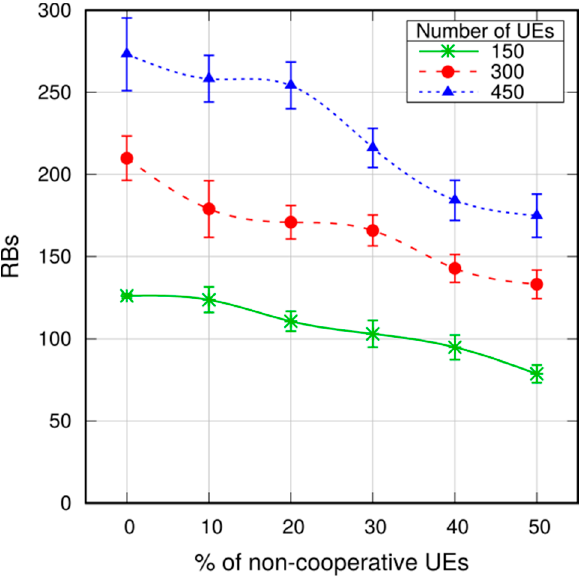
Figure 25. Avg. allocated RBs per broadcast with non-cooperative UEs.